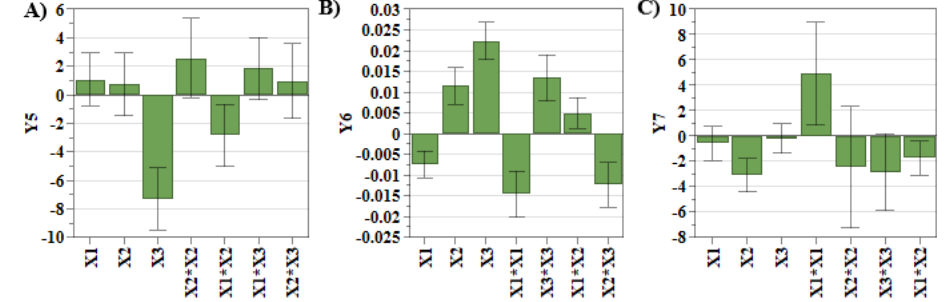
Figure 2. Coefficient plots for liposomal size ( A ), PdI ( B ) and zeta potential ( C ). X 1 : PL concentration (mM); X 2 : DOX concentration (mM); X 3 : SIM concentration (mM); Y 5 : Liposomal size (nm); Y 6 : Liposomal PdI; Y 7 : Zeta potential (mV).